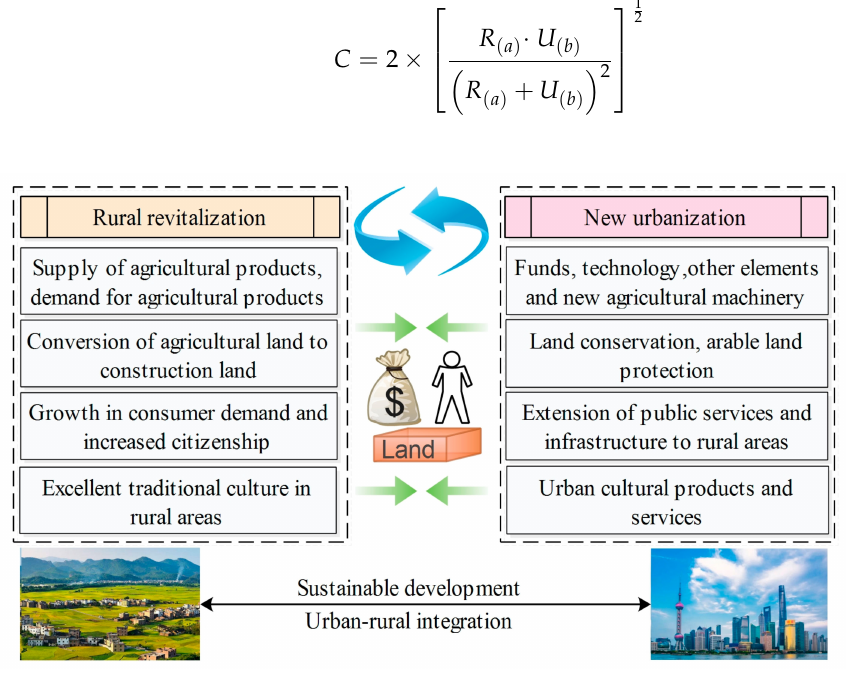
Figure 2. Integration of rural revitalization and new urbanization system. (Source: made by